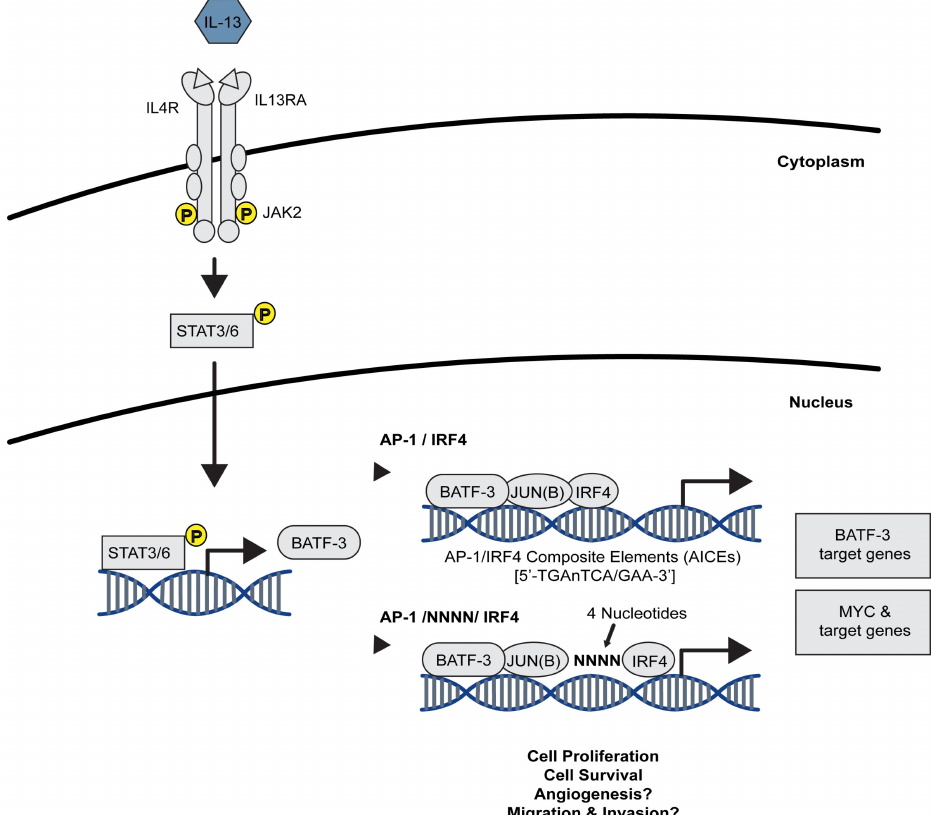
Figure 2. The described JAK/STAT/BATF/MYC signalling cascade in Classical Hodgkin Lymphoma (CHL) and Anaplastic Large Cell Lymphoma (ALCL). JAK2 activation, via IL-13 stimulation, results in the phosphorylation (yellow) of STAT3/6. STAT3/6 translocates into the nucleus where it